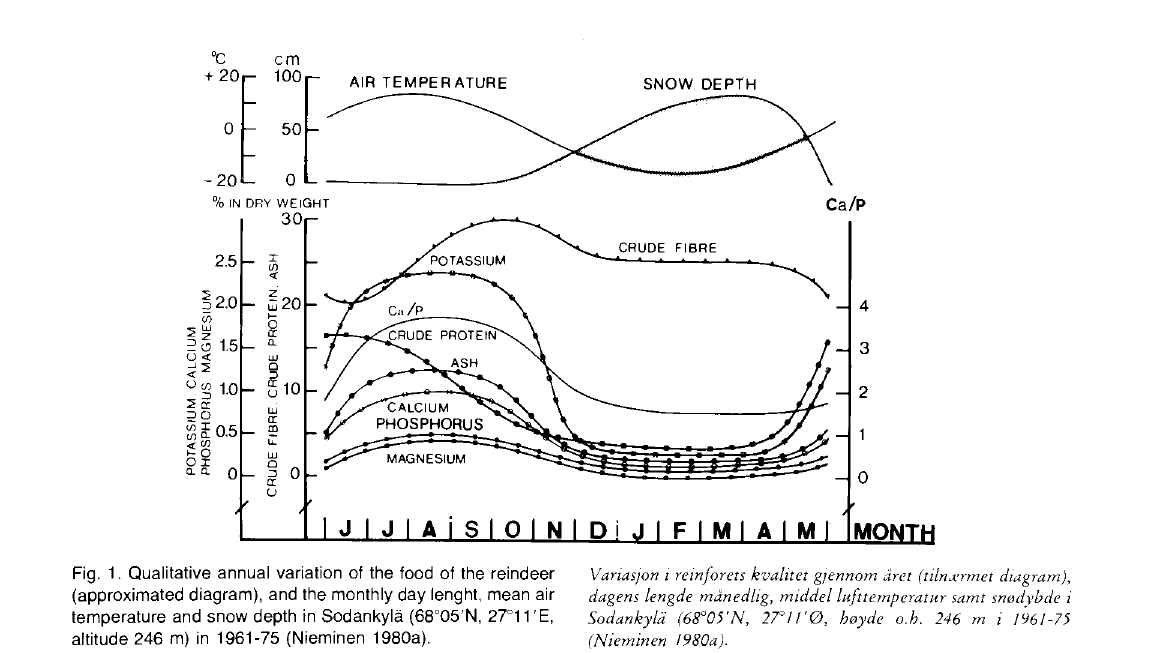
Variasjon i reinforets kvalitet gjennom dret (tilnærmet diagram), dagens lengde månedlig, middel lufttemperatur samt snødybde i Sodankyla (68°05'N, 27°11'0, høyde o.h. 246 m i 1961-75 (Niemmen